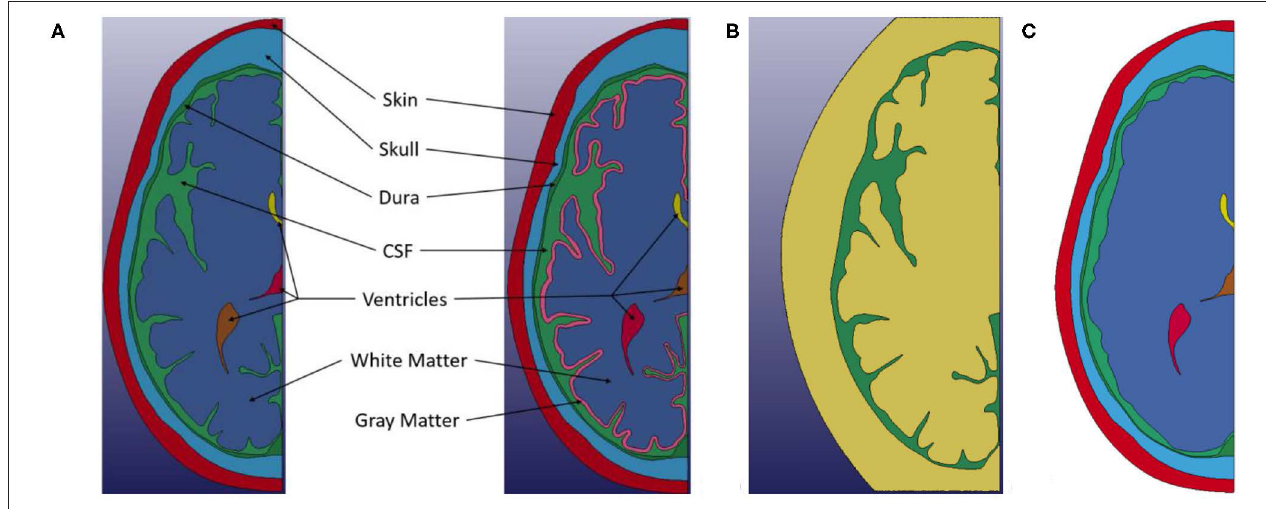
FIGURE 2 | (A) Left Geometry of non-differentiated model. (A) Right Geometry of the white and gray matter differentiated model. (B) ALE computational domain (Green) Initial region occupied by CSF material. (Yellow) Initial empty region. Only the CSF material interacts with the Lagrangian parts, but it is able to move and deform within the combined area of the Green and Yellow meshes. (C) Smooth brain model.